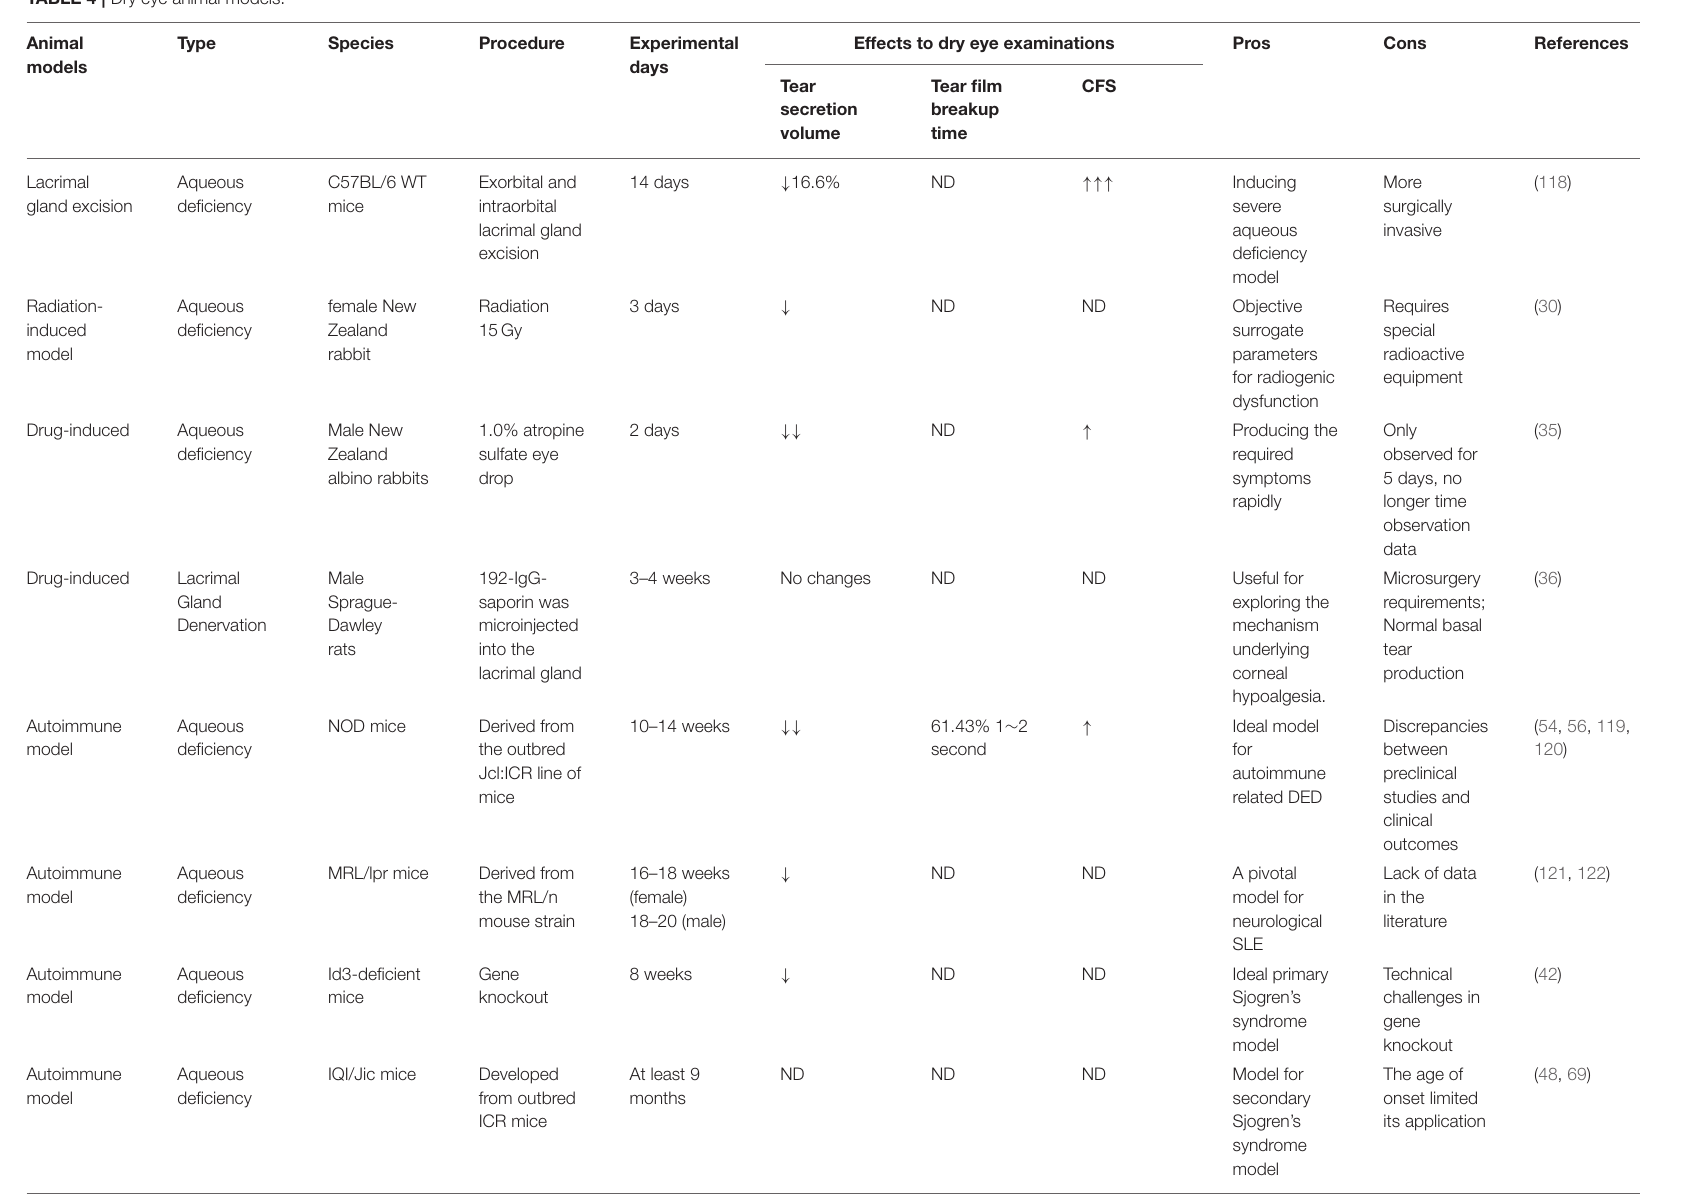
TABLE 4 | Dry eye animal